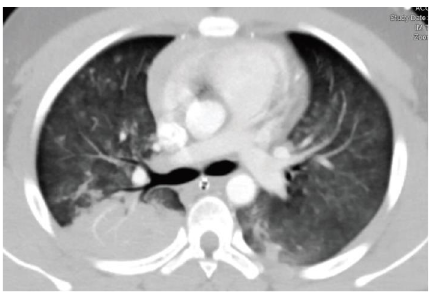
Figure 2: Axial view of CT chest scan showing bilateral alveolar ground-glass opacities with right upper lobe posterior segment consolidation.